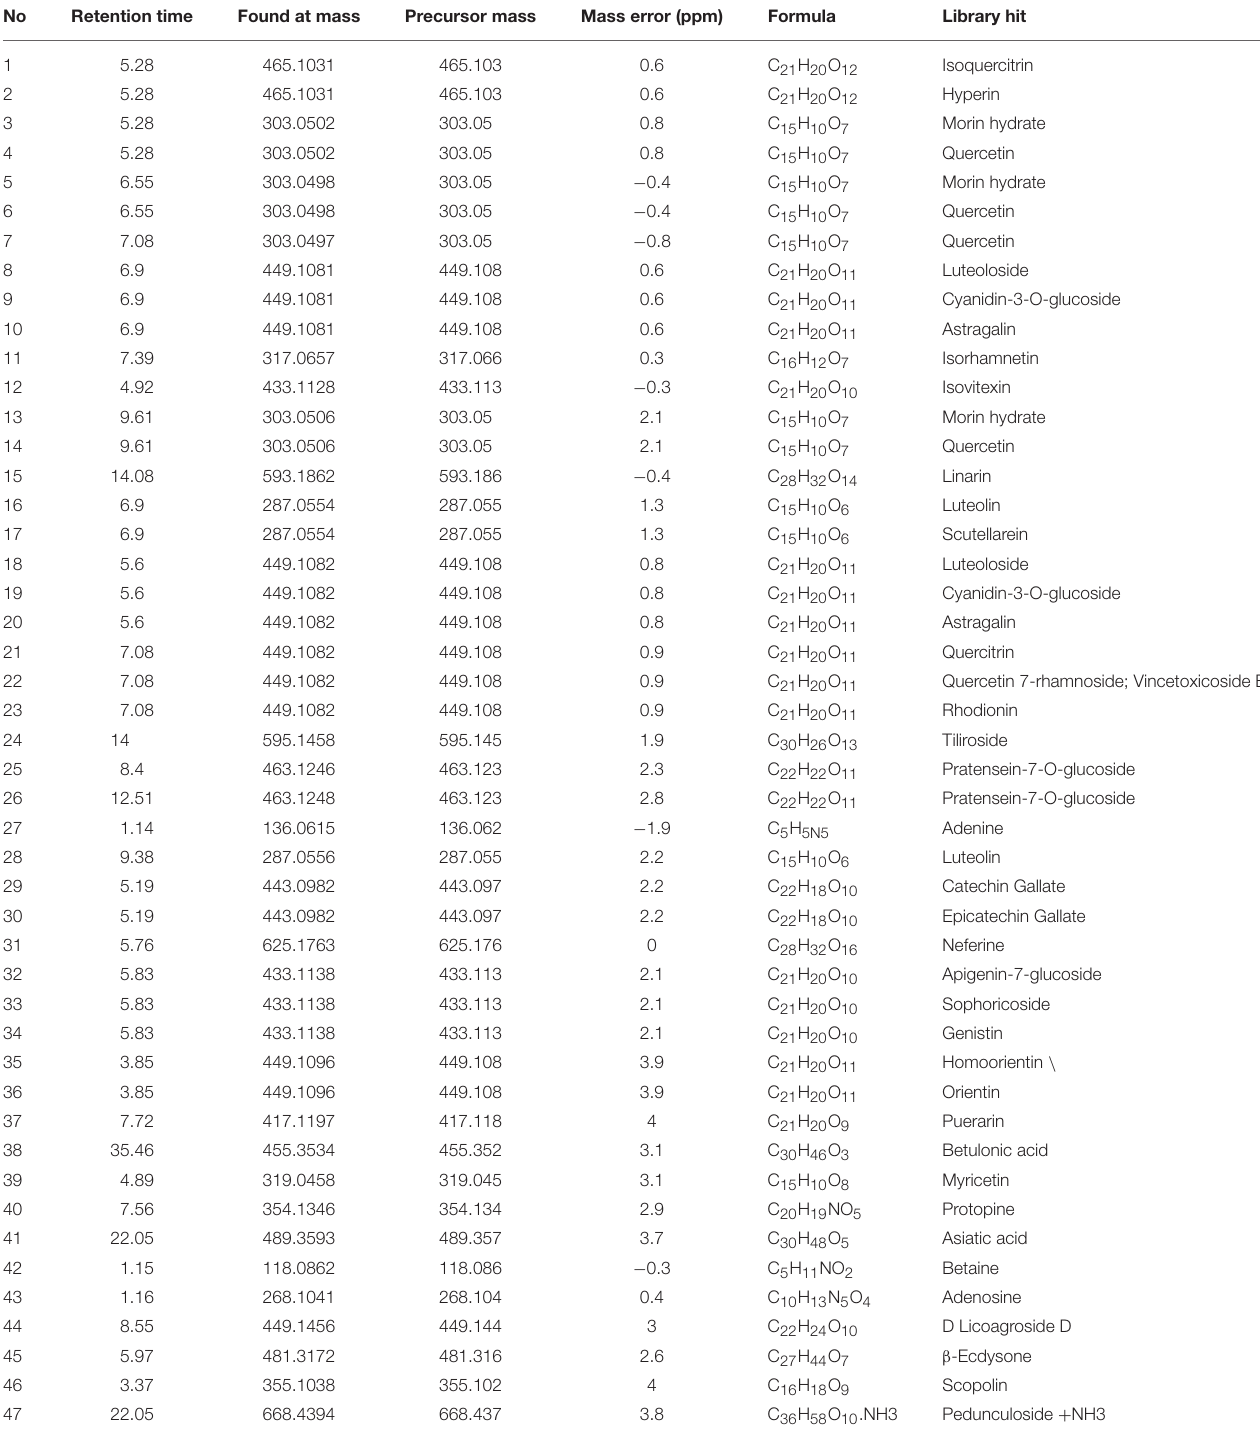
TABLE 2 | High resolution mass spectrometry data and elemental composition of PEC (Positive Ion Mode).